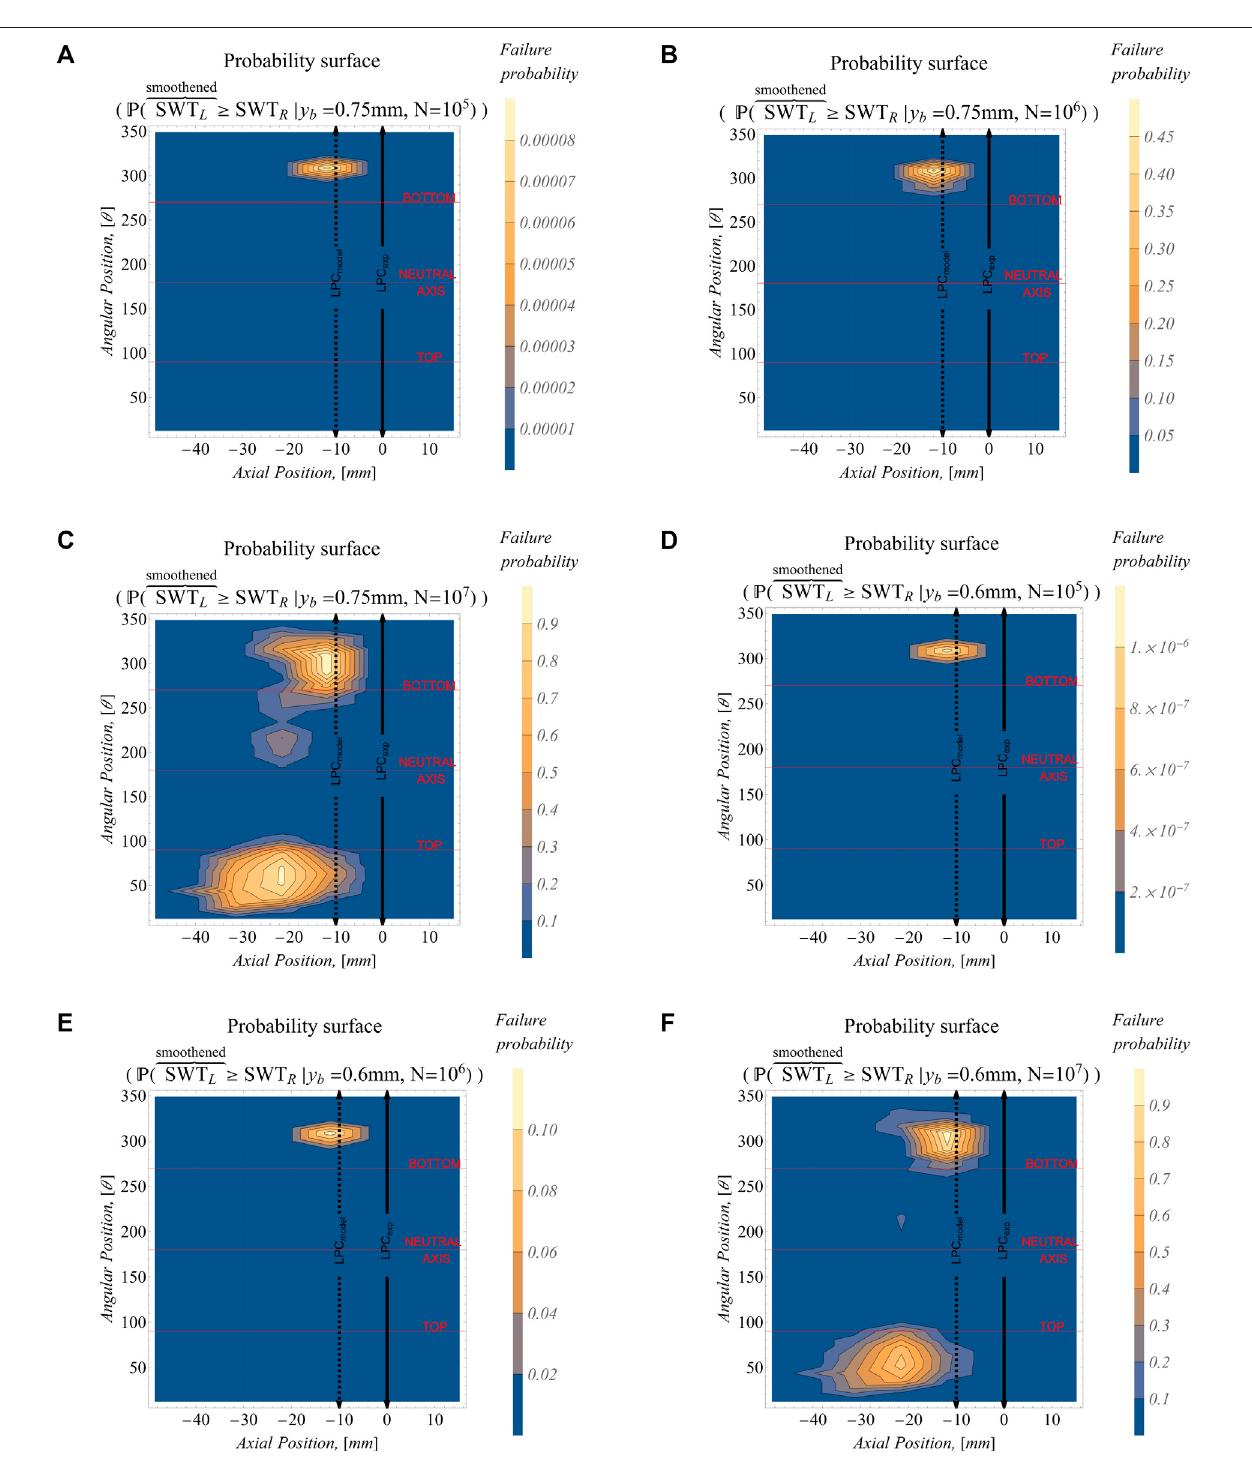
FIGURE 13 | Probability of failure for the wires in layer 4 of the Bersfort conductor at a bending amplitude of 0.75 mm (A – C) and 0.6 mm (D – F) .